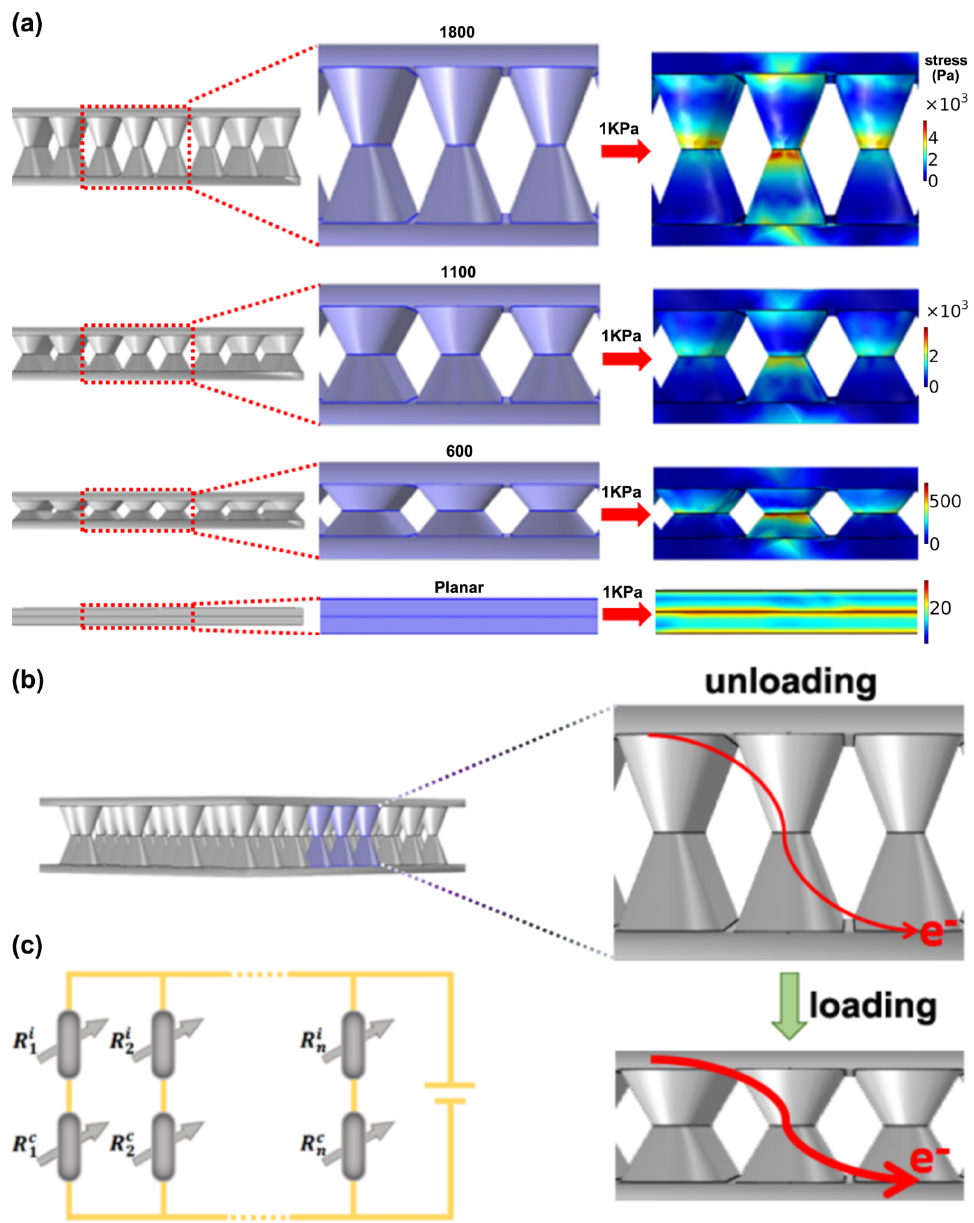
Figure 3. ( a ) The simulation shows the local stress distribution of the interlinked resistance sensor under an applied pressure of 1 kPa; ( b ) schematic diagram of the sensing mechanism under loading and unloading processes; ( c ) equivalent circuit diagram of the interlinked resistive